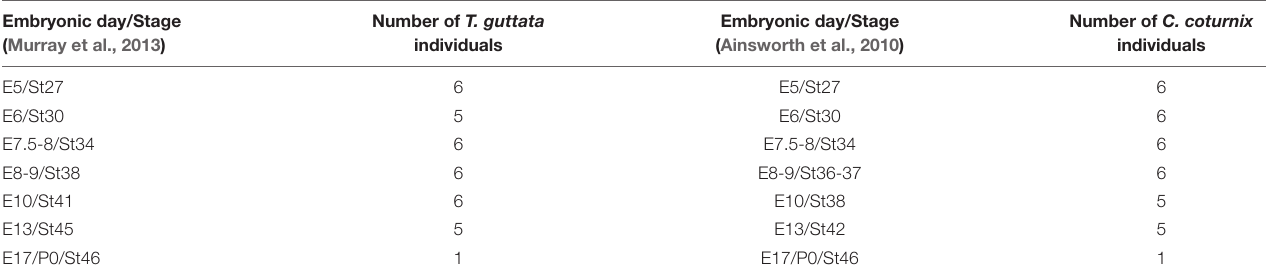
TABLE 1 | T. guttata and C. coturnix embryos and hatchlings used in the present study. Embryonic day/Stage (Murray et al., 2013)